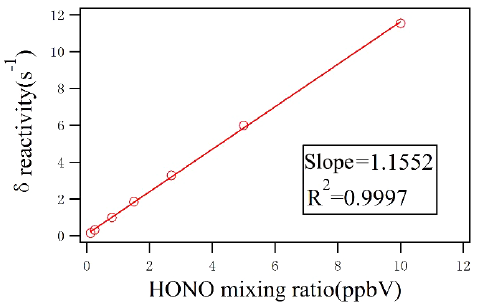
Figure 4. Nitrous acid (HONO)-correction experiments and the fit- ting curve in Heshan in